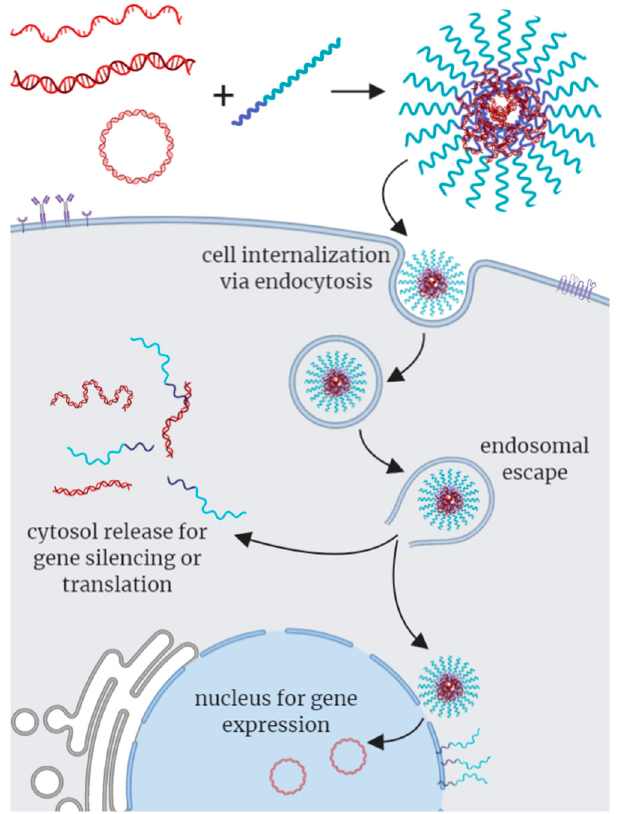
Figure 3. Schematic representation of uptake of polynucleotide-based C3Ms by cells. Single-stranded DNA, double-stranded DNA and/or plasmid DNA may form polynucleotide-based C3Ms upon complexation with a cationic-neutral block copolymer. C3Ms are internalized via endocytosis. Disruption of the endosomal membrane leads to escape of the cargo, after which the genetic material can be released into the cytosol, or the C3M may interact at the nuclear membrane to release the DNA into the nucleus.